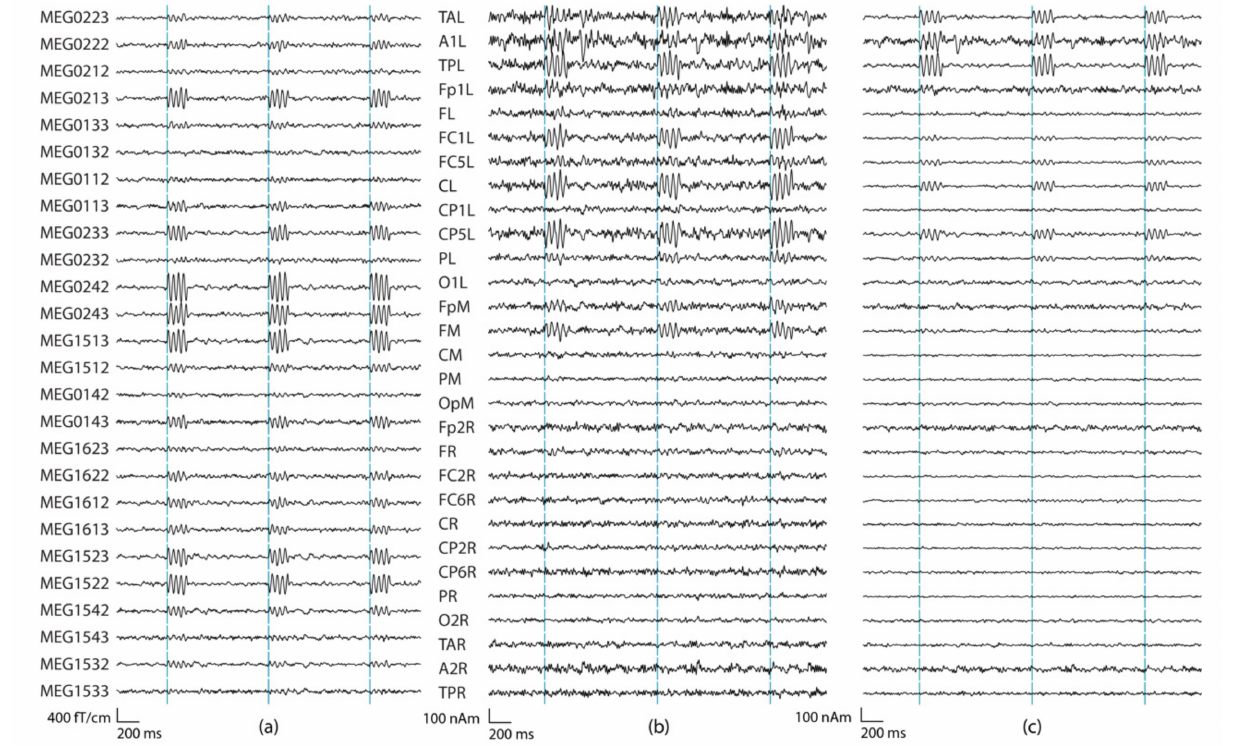
Figure 5. Examples of sensor-level and source-montages signals where the reconstructed activity is detectable at multiple sensor-level and source-montage channels. ( a ) Left temporal gradiometers. ( b ) Source montage waveforms at all 29 regional source locations of BR29 with no regularization, ( c ) and with 2% regularization. The source montage dipole orientations were optimized according to Equation (7). The source was a tangential dipole with the amplitude of 100 nAm in a left temporal location. The highest sensor SNR was 40 dB (MEG0242), and highest source montage SNR was 38 dB (TPL; distance to the nearest sensor is 48 mm, distance to the source montage channel with the highest SNR is 24 mm, Q = 99 nAm). In ( a ) Ndt1 = 46, in ( b ) Ndt2 = 6, and in ( c ) Ndt2 =